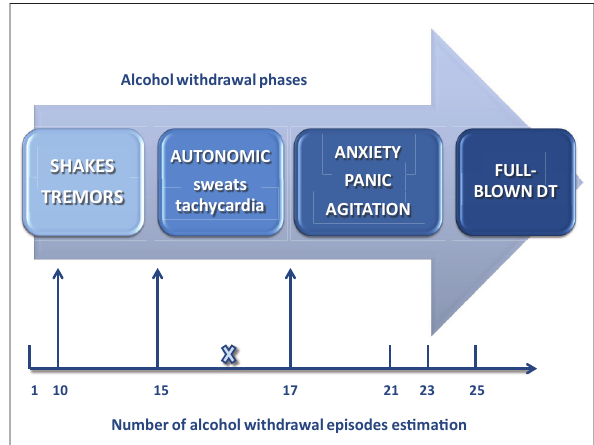
Fig. 1. The kindling phenomenon, adapted from Post 2002 (ref. 30